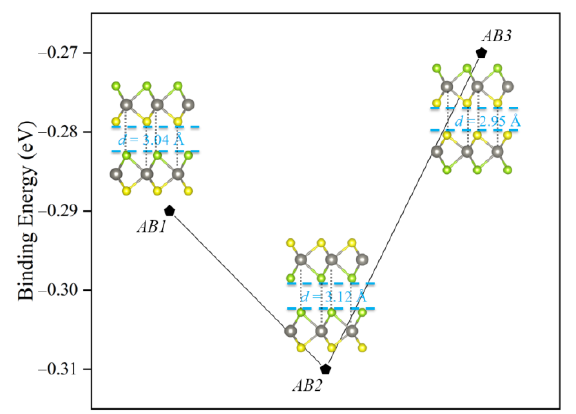
Figure 1. The atomic structures of WSSe bilayer with different stacking patterns ( AB1 , AB2 , and AB3 ) and their respective binding energy.